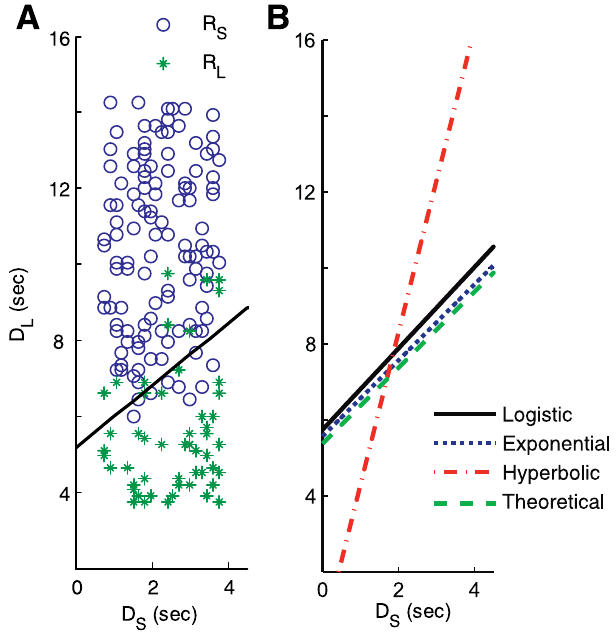
Figure 3. Reward Choice as a Function of Delays (A) Example of a subject’s reward choice as a function of delays. At each trial, the subject had the choice between a large reward R L and a small reward R S . The indifference line (solid line) was obtained with a logistic regression model (see Materials and Methods). (B) Comparison of average indifference lines derived from the experi- ment with the theoretical indifference line that maximizes total gain in the experiment. Black solid line: average indifference line for all subjects obtained with the logistic regression model. Dotted blue line: average indifference line for all subjects obtained by fitting an exponential discounting model (the slope of the indifference line is 1). Dash-dotted red line: average indifference line for all subjects obtained by fitting a hyperbolic model (the slope of the indifference line is 4). Dashed green line: theoretical indifference line that maximizes the total gain in the experiment (the slope of the indifference line is 1).